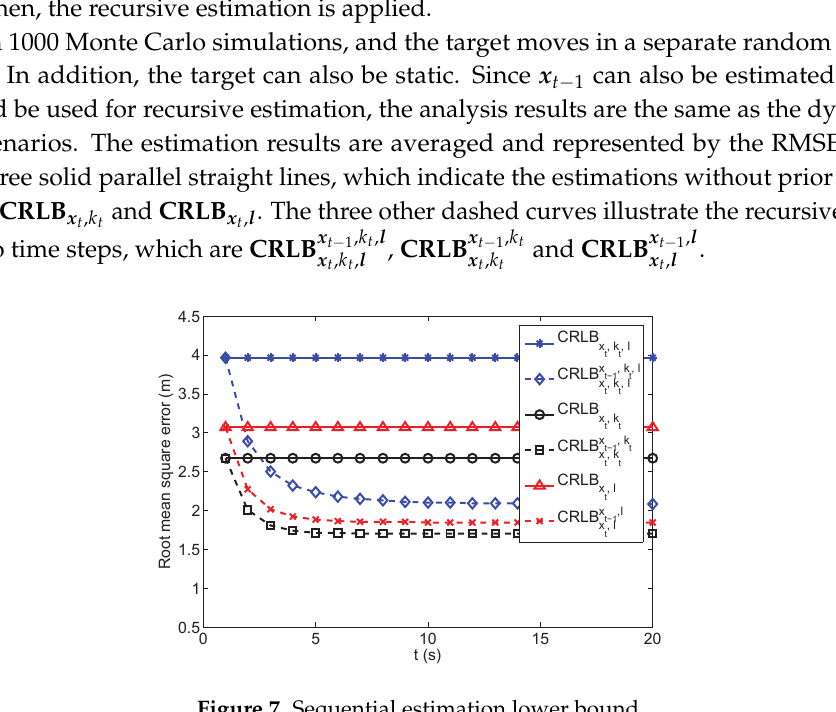
Figure 7. Sequential estimation lower